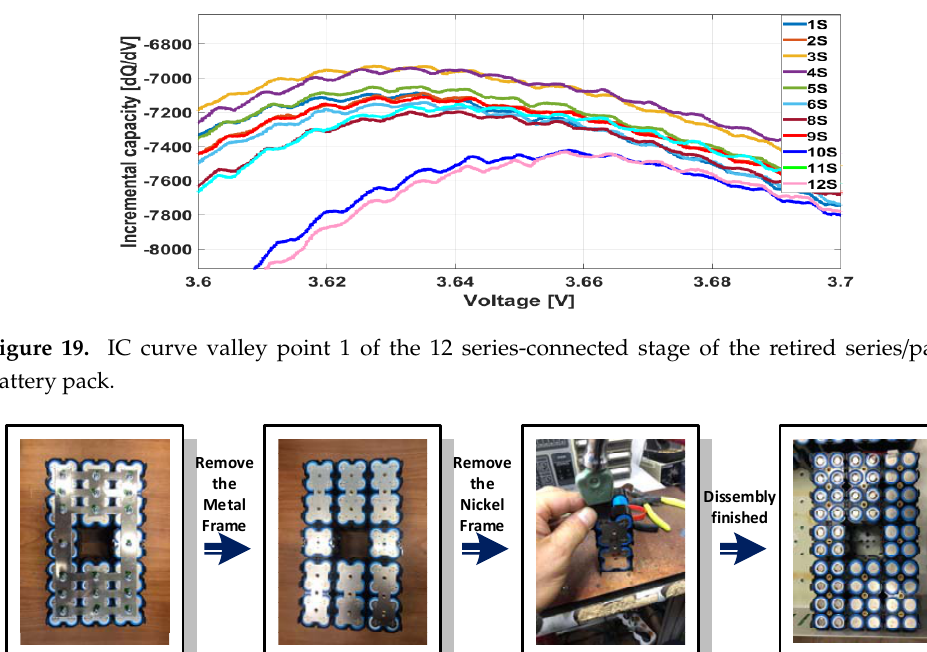
Figure 20. Disassembling of the retired series/parallel battery pack.